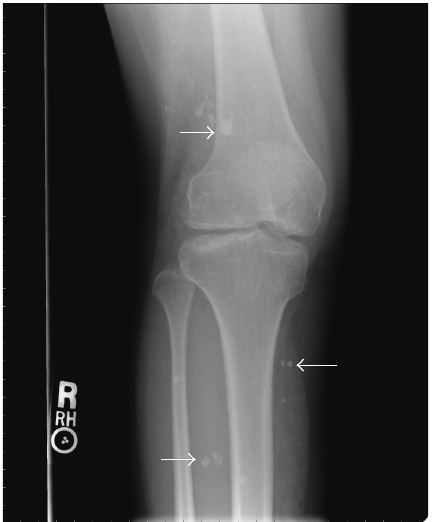
Figure 3: Anteroposterior radiograph of the knee demonstrating multiple venous calcifications (phleboliths) (arrows).